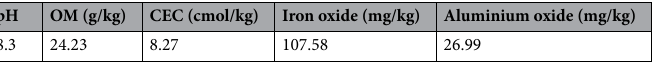
Table 1. Basic physical and chemical properties of